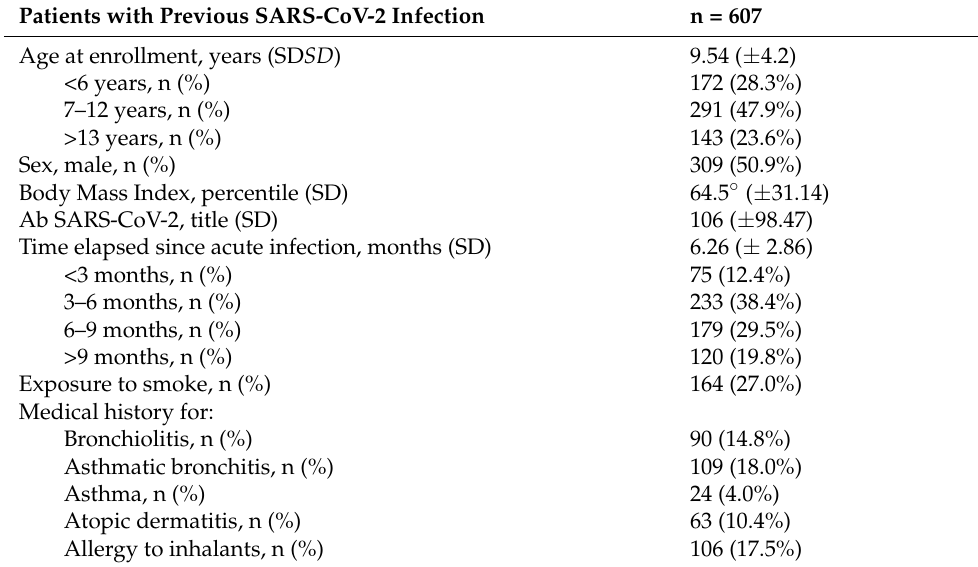
Table 1. Clinical and demographic characteristics of patients. Variables are expressed as frequencies (percentages) and means ( ±